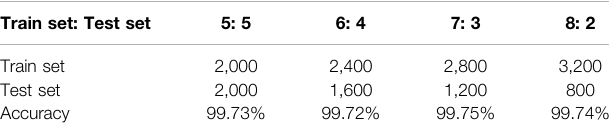
TABLE 3 | Accuracy under different ratio of training and testing